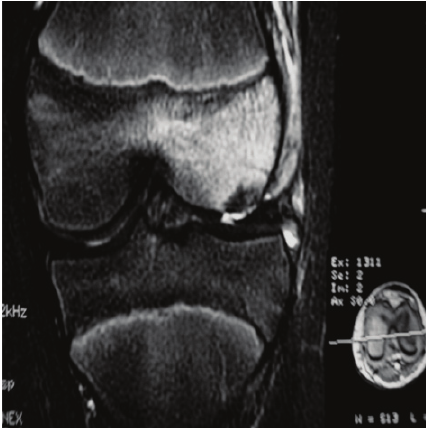
Figure 1: Preoperative MRI image of an osteochondral fracture of the lateral condyle in an 11-year-old